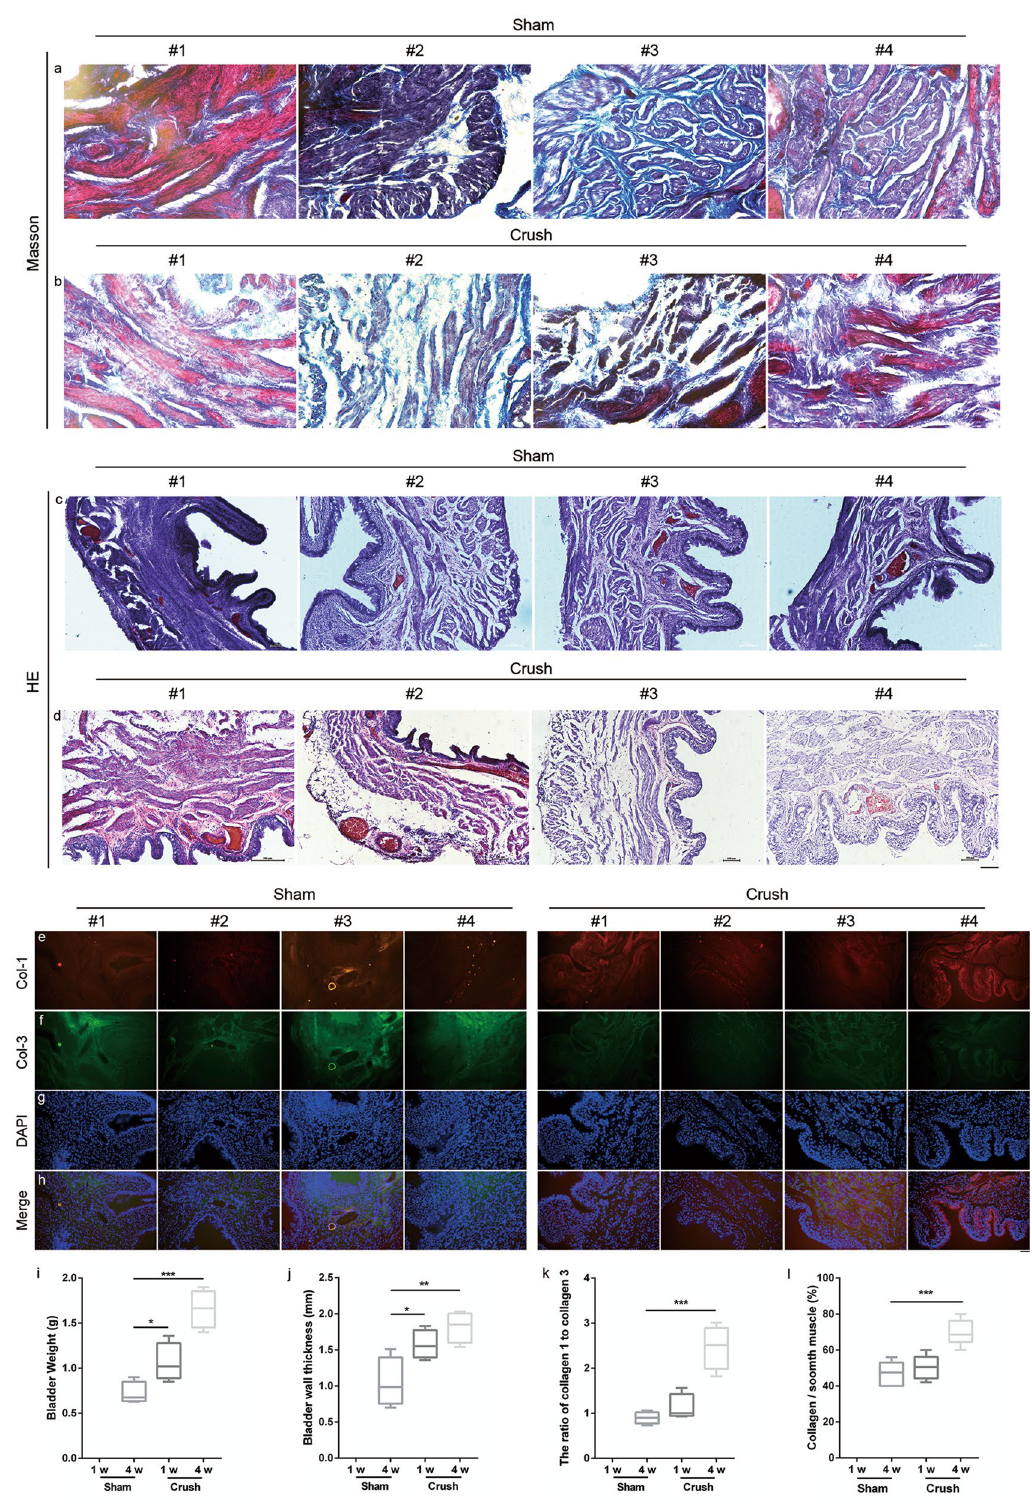
Figure 6. Histological evaluation and immunohistostaining of bladder at 1 w and 4 w. (a#1-a#4 and b#1-b#4) Masson’s trichrome staining of bladder wall (20 ×). (c#1-c#4 and d#1-d#4) H&E staining of bladder wall (10 ×) Scale bar: 100 μm. (e#1-e#4, f#1-f#4, g#1-g#4 and h#1-h#4 in sham; e#1-e#4, f#1-f#4, g#1-g#4 and h#1-h#4 in crush) Immunostaining of Col-1, Col-3, DAPI and Merge image of bladder (20x). Scale bar: 100 μm. (i-l) Bladder weight, bladder wall thickness, the ratio of collagen 1 to collagen 3 and collagen/smooth muscle at 1 w and 4 w. Data was represented as mean ± SEM. Significance levels were set at * P < 0.05, ** P < 0.01, *** P <